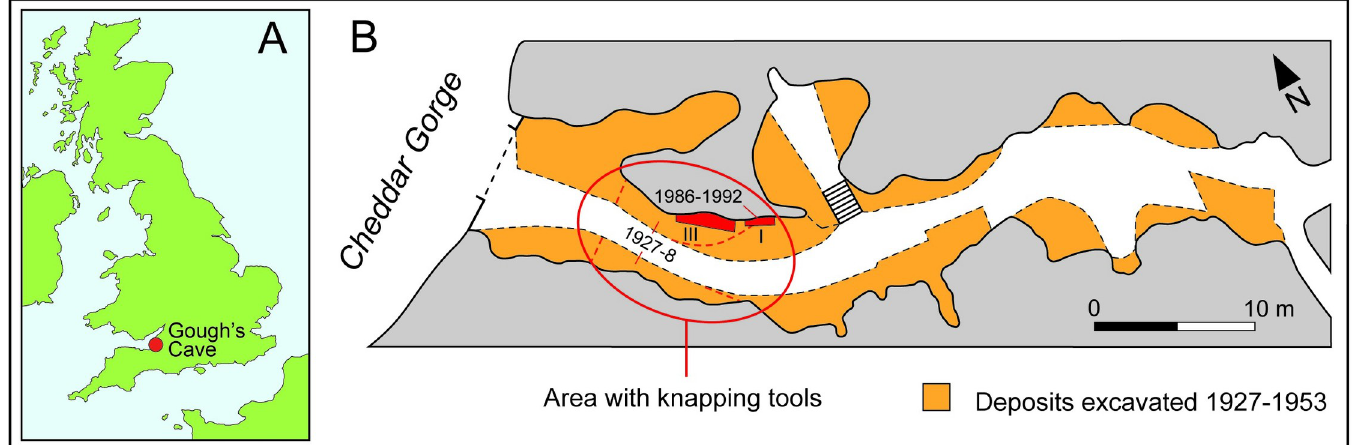
Fig 1. A. Location of Gough’s Cave. B. Plan of the outer part of Gough’s Cave showing where the knapping tools were recovered. Five of the eight knapping tools from Parry’s excavation were found in November 1927, and the other specimens recorded for that year, as well as the phalanx from the 1987 excavation (Area I), were found in the same area of the ‘entrance’ (bounded by the red oval). Plan based on